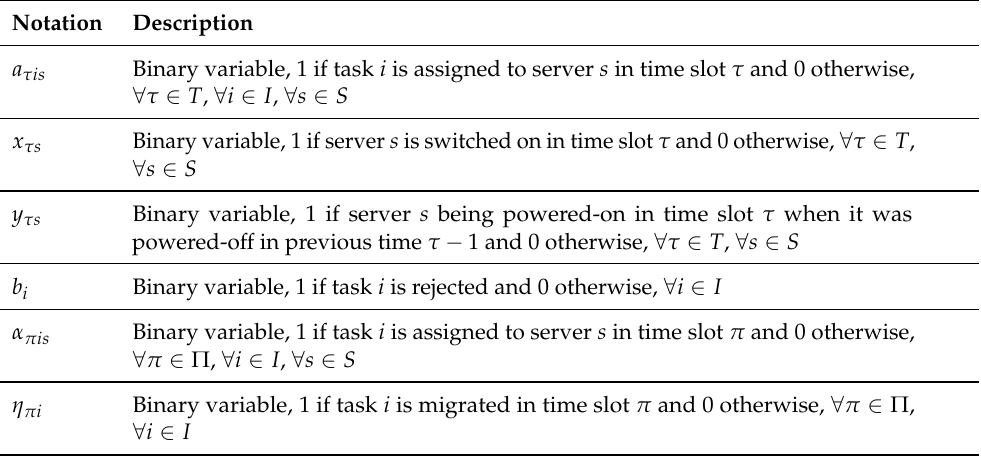
Table 3. Decision